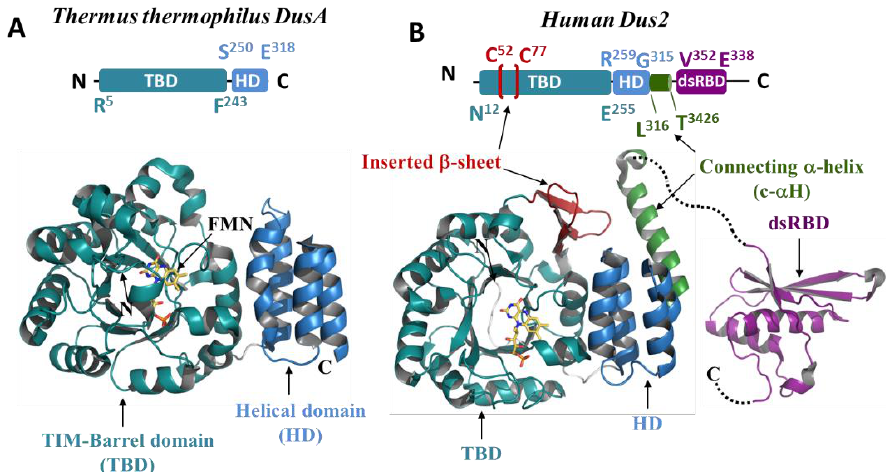
Figure 2. Crystallographic structures of Dus. ( A , B ) crystal structures of T. thermophilus DusA (PDB: 3B0V), human Dus2 without the dsRBD (PDB: 4XP7), and the dsRBD of hDus2 (PDB: 4WFT), respectively. The TIM-barrel domain (TBD) appears in teal, while the helical domain (HD) is in blue, the inserted beta-sheet in red, the connecting alpha-helix (c- α H) in green, and the dsRBD in purple. The FMN coenzyme is denoted in yellow. Above each of the structures is a scheme of the modular organization of Dus2, in which the delineation of each domain is shown.